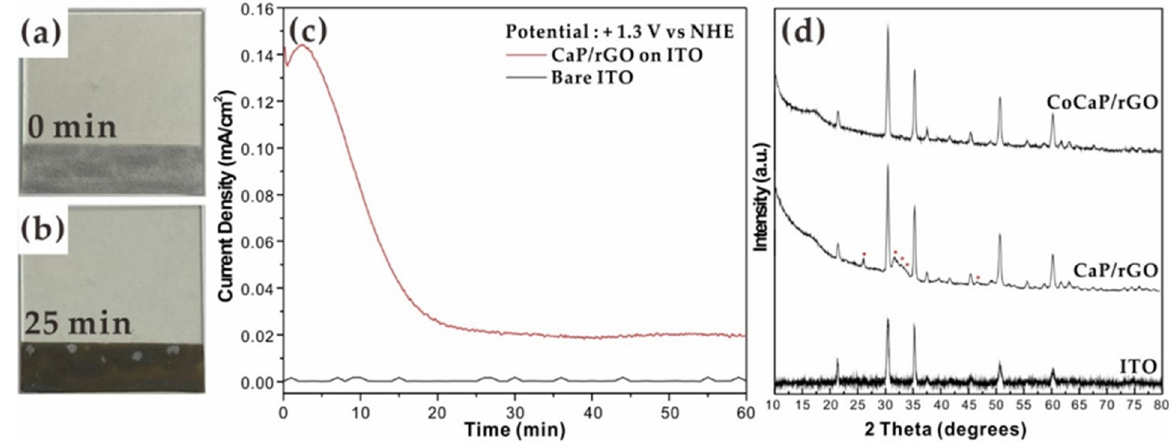
Figure 1. Photographs of ( a ) CaP/rGO and ( b ) CoCaP/rGO film on ITO after anodic electrolysis for 25 min. ( c ) Current density for anodic electrolysis at +1.3 V vs. NHE in 20 mM Co 2+ . ( d ) XRD patterns of CaP/rGO, CoCaP/rGO loaded on ITO electrode, CaHPO 4 (monetite) and ITO electrode.